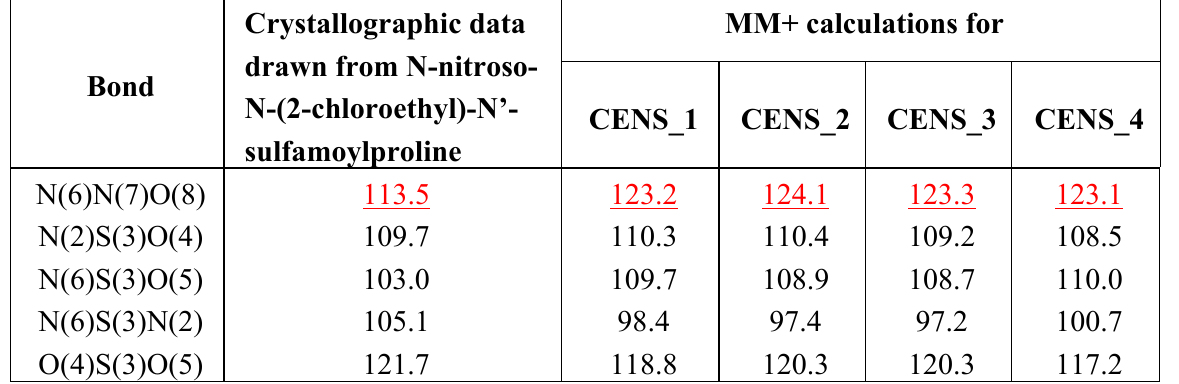
Table 4: Comparison of bond angle (°) parameters obtained by X-ray crystallography for the common fragment of the N-nitroso-N-(2-chloroethyl)-N’-sulfamoylproline and that with those obtained by molecular mechanics calculations.